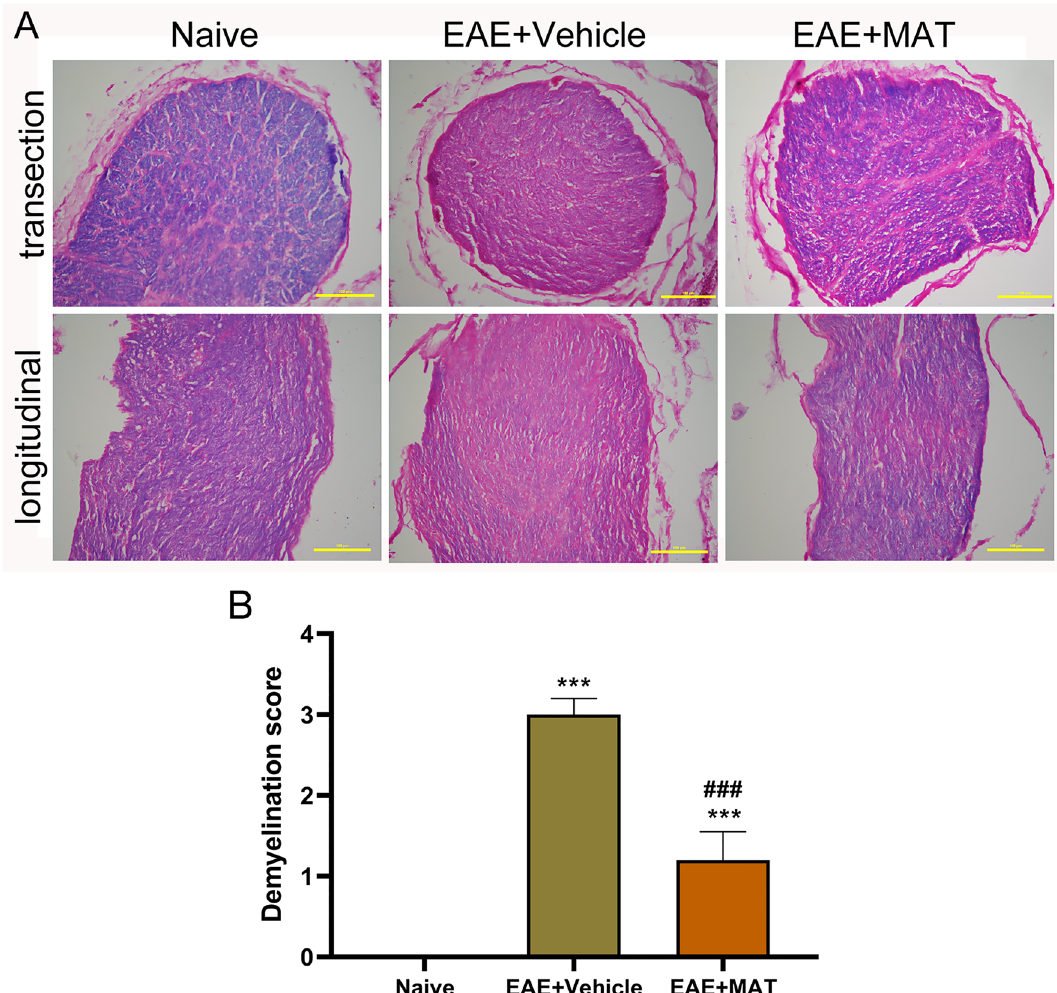
Figure 4. MAT attenuated demyelination in the optic nerve ( A ) To confirm whether MAT can protect the optic nerve from demyelination, both sides of optic nerves were isolated from rats in Fig. 1 and stained with Luxol fast blue (LFB), which stains myelin ( A ). Scale bars = 100 µm. ( B ) Mean scores of demyelination. For demyelination: 0, none; 1, rare foci; 2, a few areas of demyelination; and 3, large (confluent) areas of demyelination. All results are expressed as mean ± SD (n = 40 per group: both transverse and longitudinal sections, both sides of optic nerves from 10 rats per group; 2 × 2 × 10 = 40 each group). Multiple comparisons were performed using one-way ANOVA, followed by Student–Newman–Keuls test. *** P < 0.001, comparison with the naive group. ### P < 0.001, comparisons between vehicle- and MAT-treated